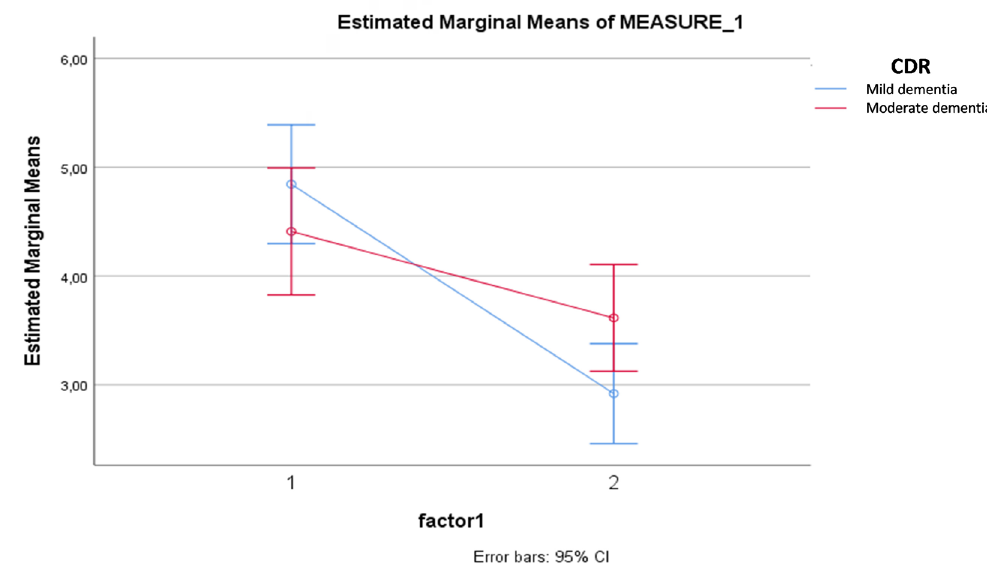
Figure 1. Difference in the extroversion factor scores between the